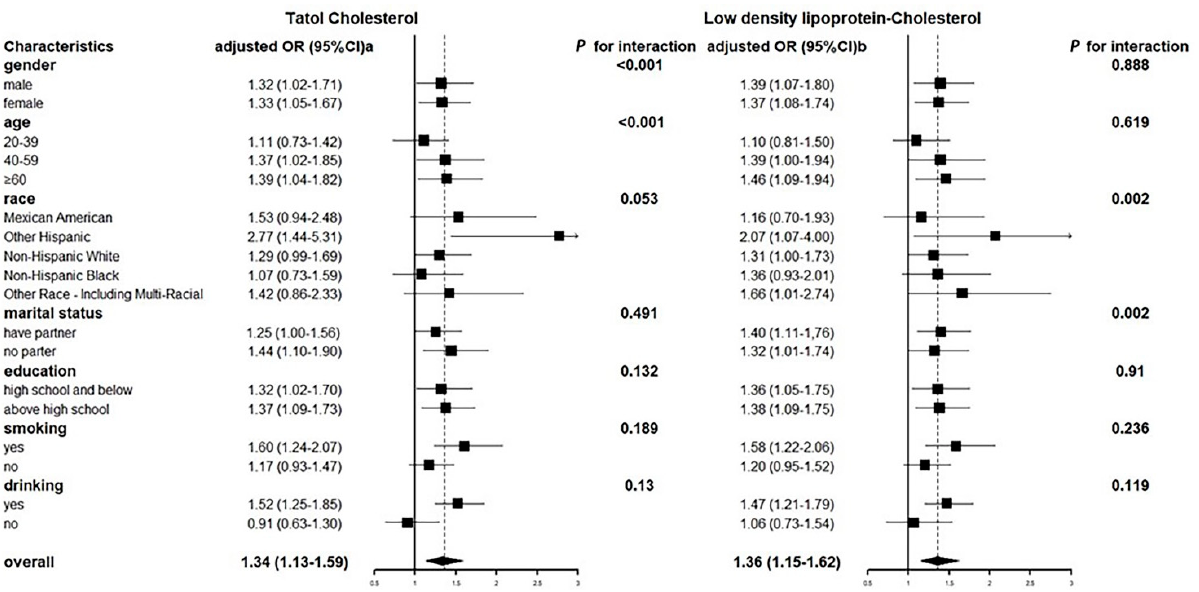
Figure 3. Odds ratios of TC and LDL-C for total urinary arsenic concentrations (µg/L) 80% versus 20% by participant characteristics.